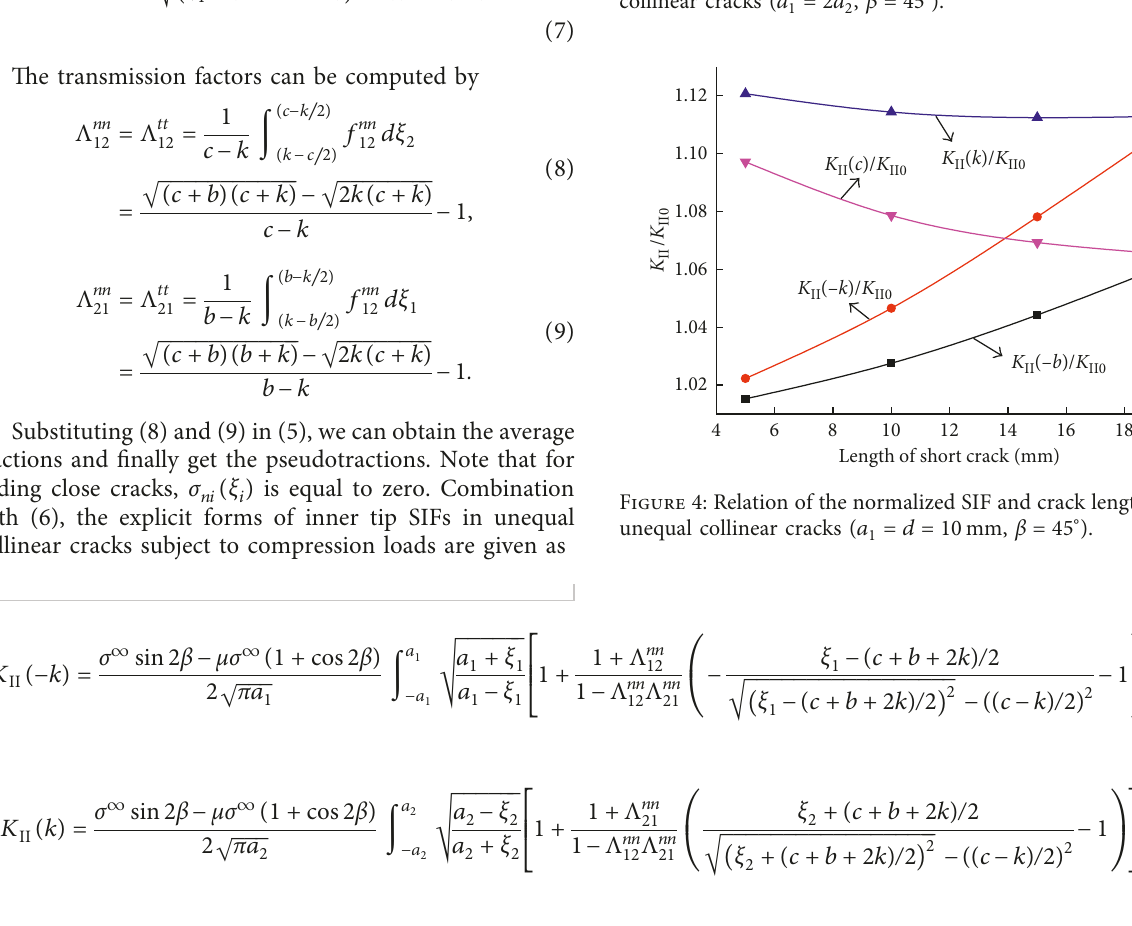
1 for two unequal